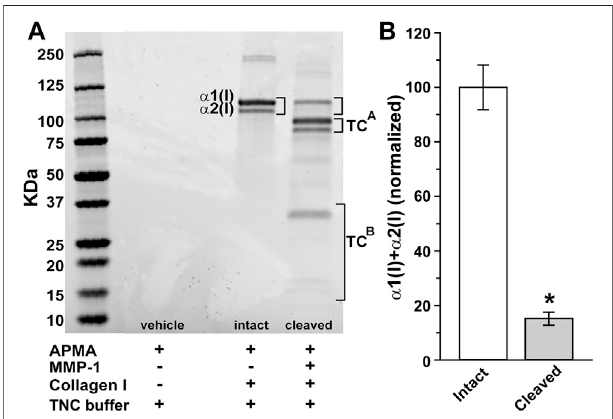
FIGURE 1 | Digestion of collagen I by matrix metalloproteinase 1 (MMP- 1). (A) SDS-PAGE electrophoresis gel shows dual bands representing reaction products for intact α 1(I) and α 2(I) chains of human type 1 atelocollagen (brackets). Cleavage with activated MMP-1 (60 nM) reduces both α 1(I) and α 2(I) while increasing their ¾ (TC A ) and ¼ (TC B ) fragments, respectively. (B) Level of combined full length of α 1(I) and α 2(I) chains reduce by 85% following MMP-1 cleavage relative to intact collagen (*, p < 0.001; n (cid:1) 9 for each condition).